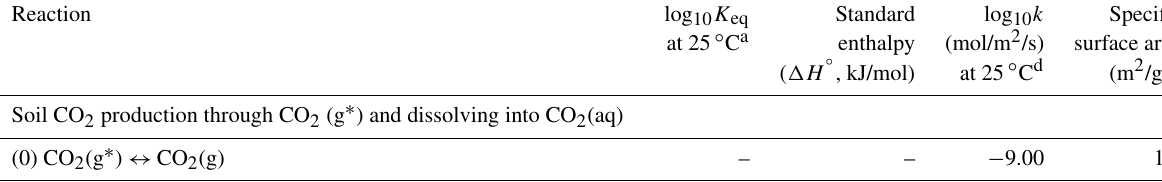
Table 1. Key reactions and kinetic and thermodynamic parameters. Reaction log 10 K